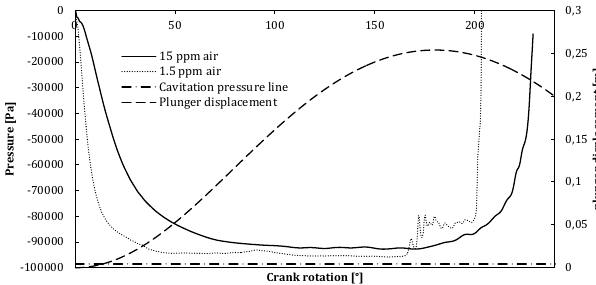
Figure 5. Pump chamber pressure history. A liquid poorer in air mass fraction is affected by a higher Figure 5: Pump chamber pressure history. A liquid poorer in air pressure drop. mass fraction is affected by a higher pressure